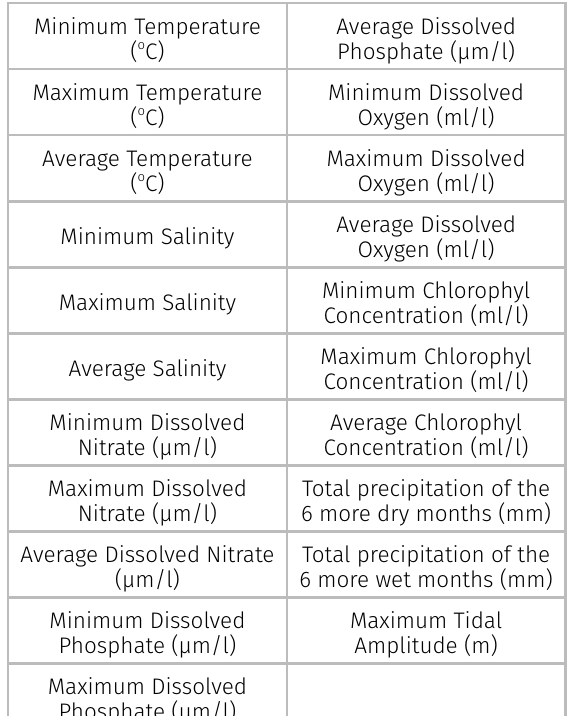
Table I. Abiotic factors used in the multivariate similarity analysis using Euclidian